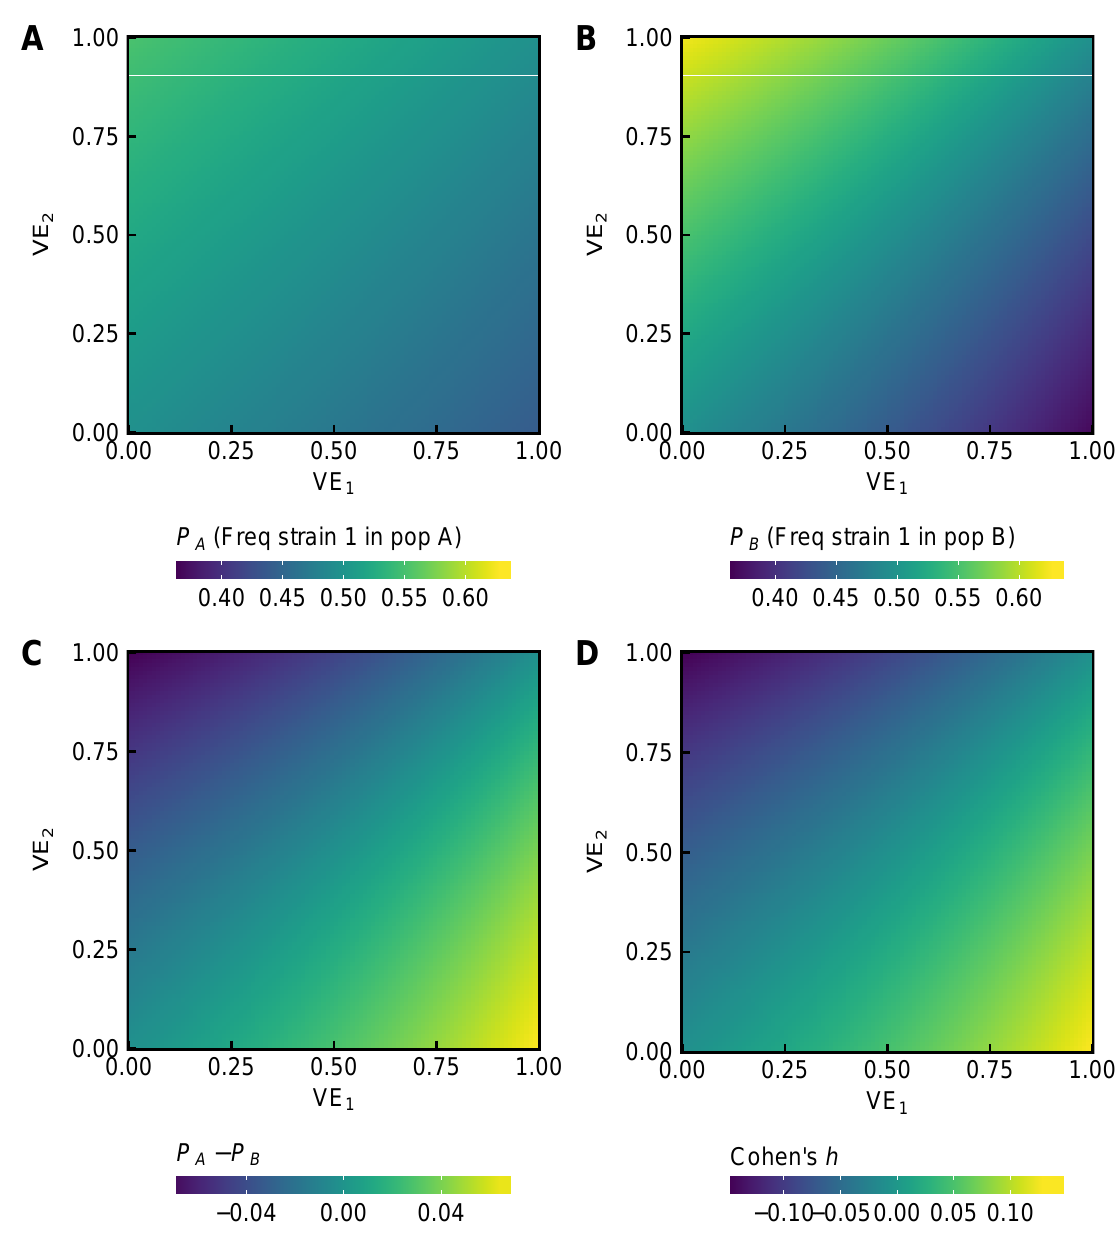
Figure A11. Simulated frequencies of two strains s 1 and s 2 , circulating in populations A (with 20% vaccine coverage) and B with (40% vaccine coverage), calculated according to Equation (A23). Given the vaccine effectiveness against both strains, we calculated the fraction of strain 1 (out of strains 1 and 2) in ( A ) population A and ( B ) population B . The absolute difference in frequencies between regions is shown in ( C ), and the Cohen’s h effect size is shown in ( D ). These quantities are used to calculate statistical power in Figure